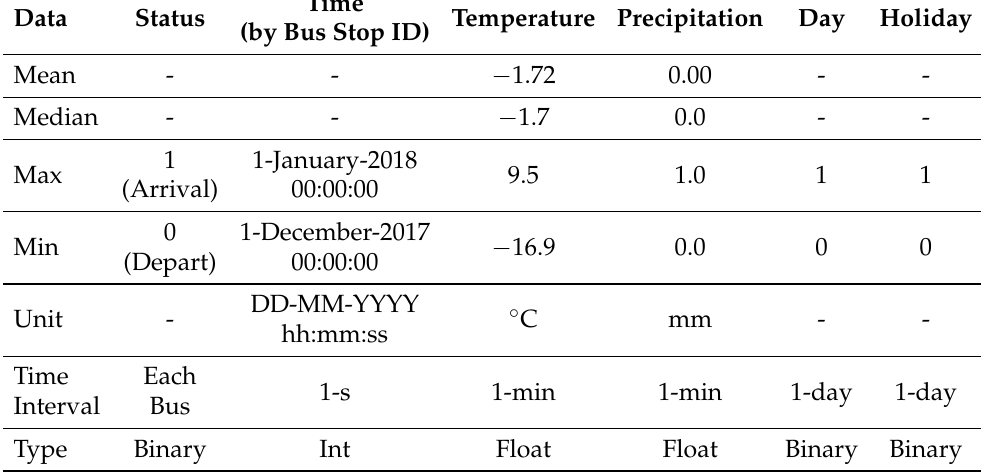
Table 2. Basic bus data